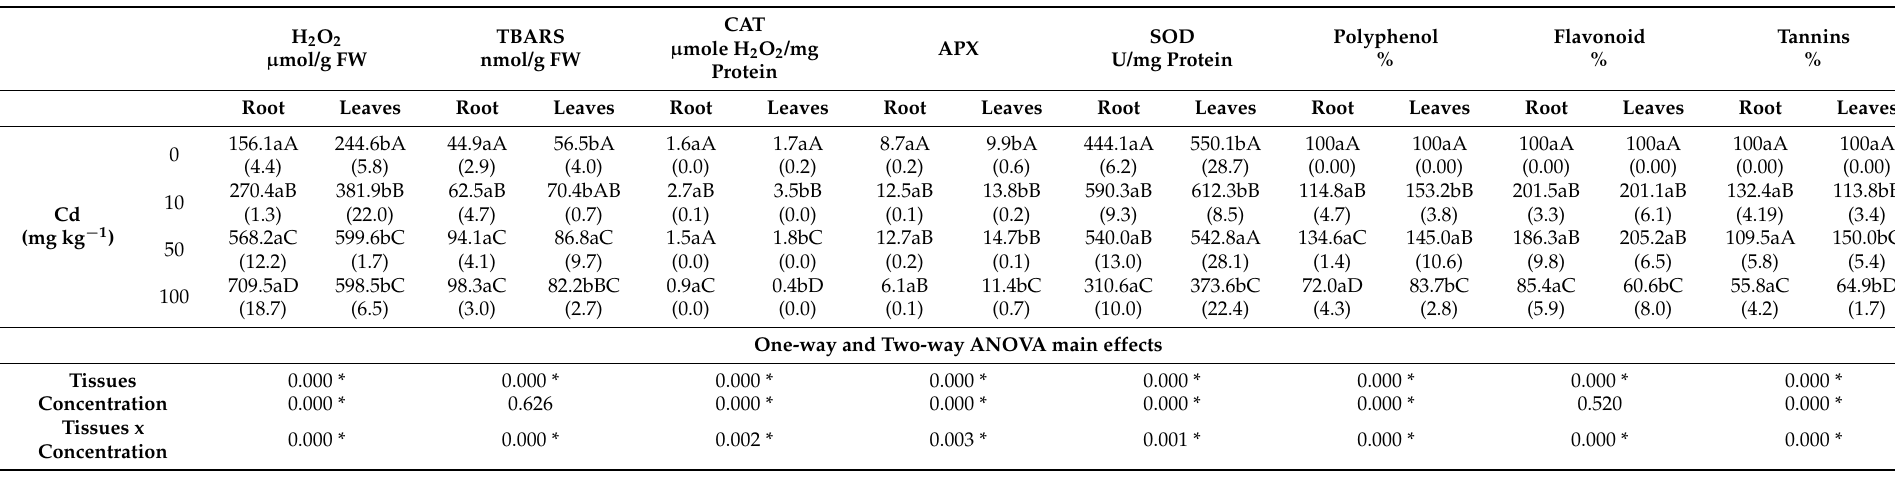
Table 4. Monitoring of elements of oxidative and antioxidative state of date palm plantlets subjected to different Cd, Cu, and Cr